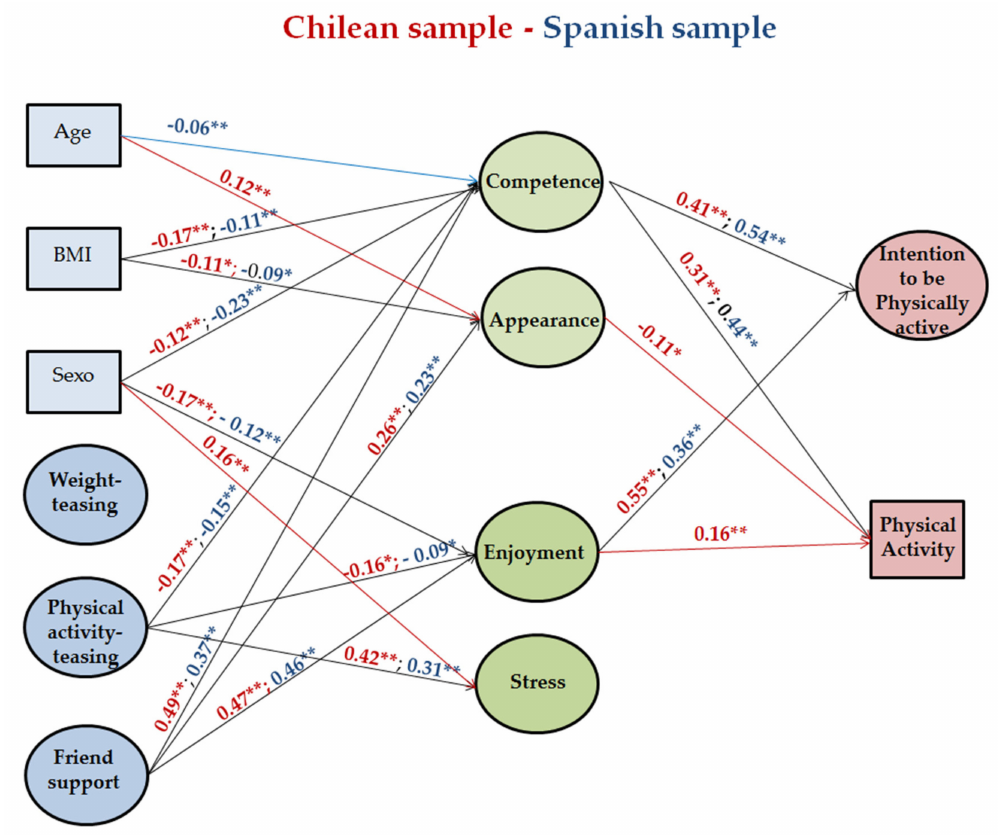
Figure 2. The multi-group final model where standardized parameters of the paths between countries can be compared. Covariances, correlations, and nonsignificant paths are omitted for presentation clarity. Chilean results are in red, Spanish results are in blue. ** p < 0.01, * p <